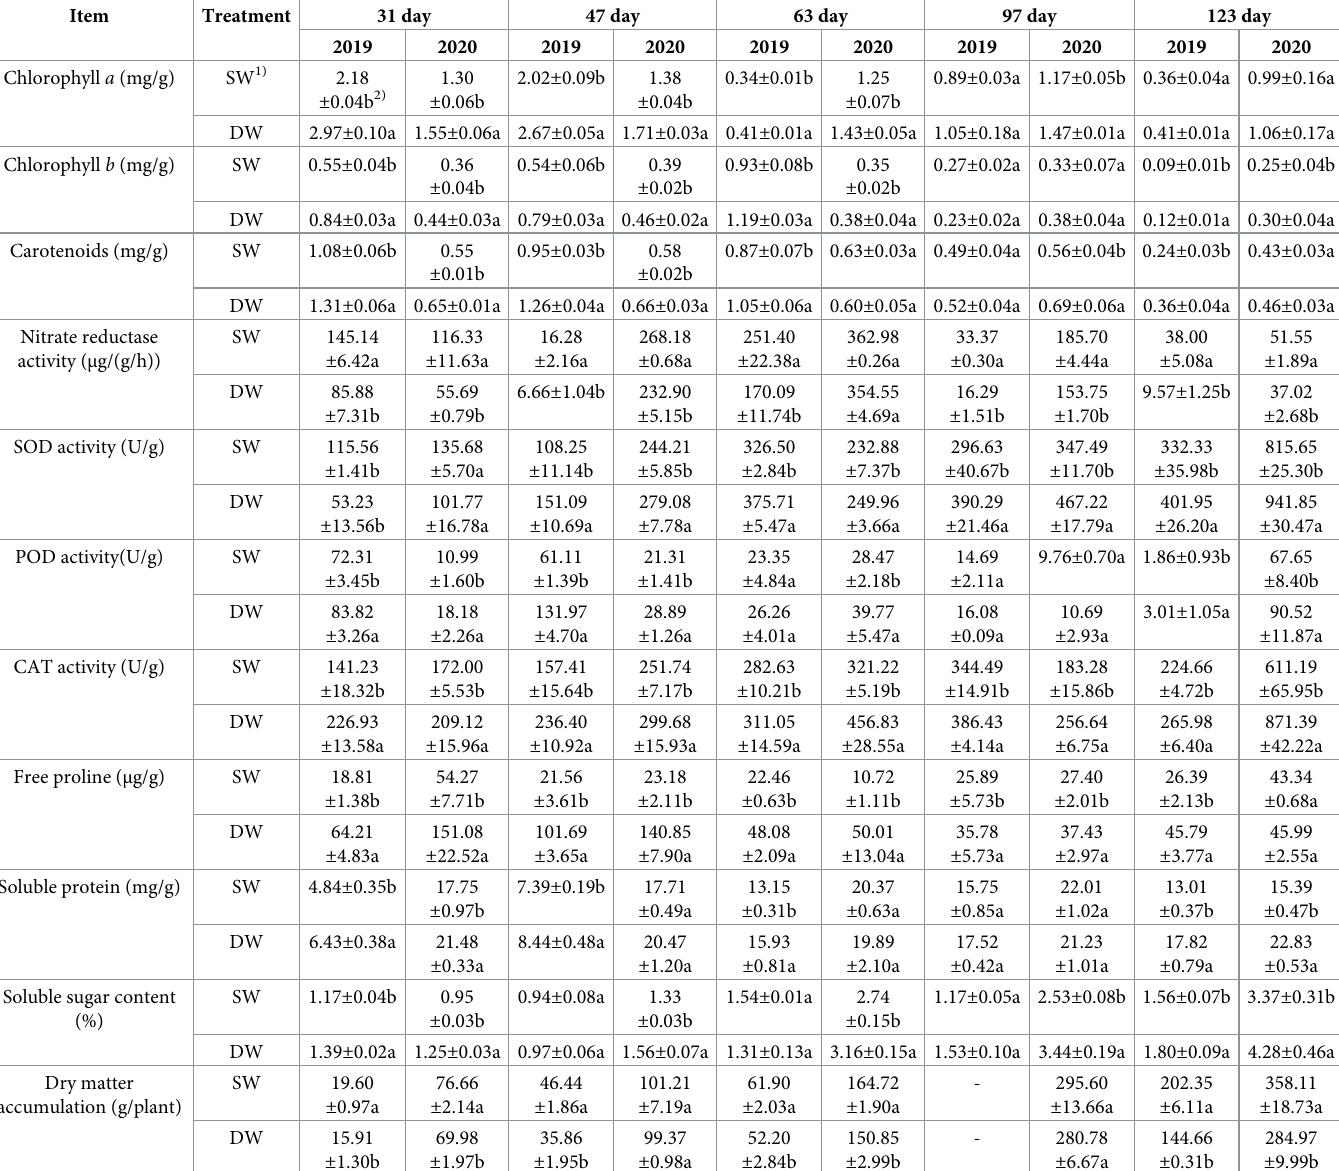
Table 2. The pigment content, nitrate reductase activity, antioxidant enzyme activity, osmotic regulating substance content and dry matter accumulation. Item Treatment